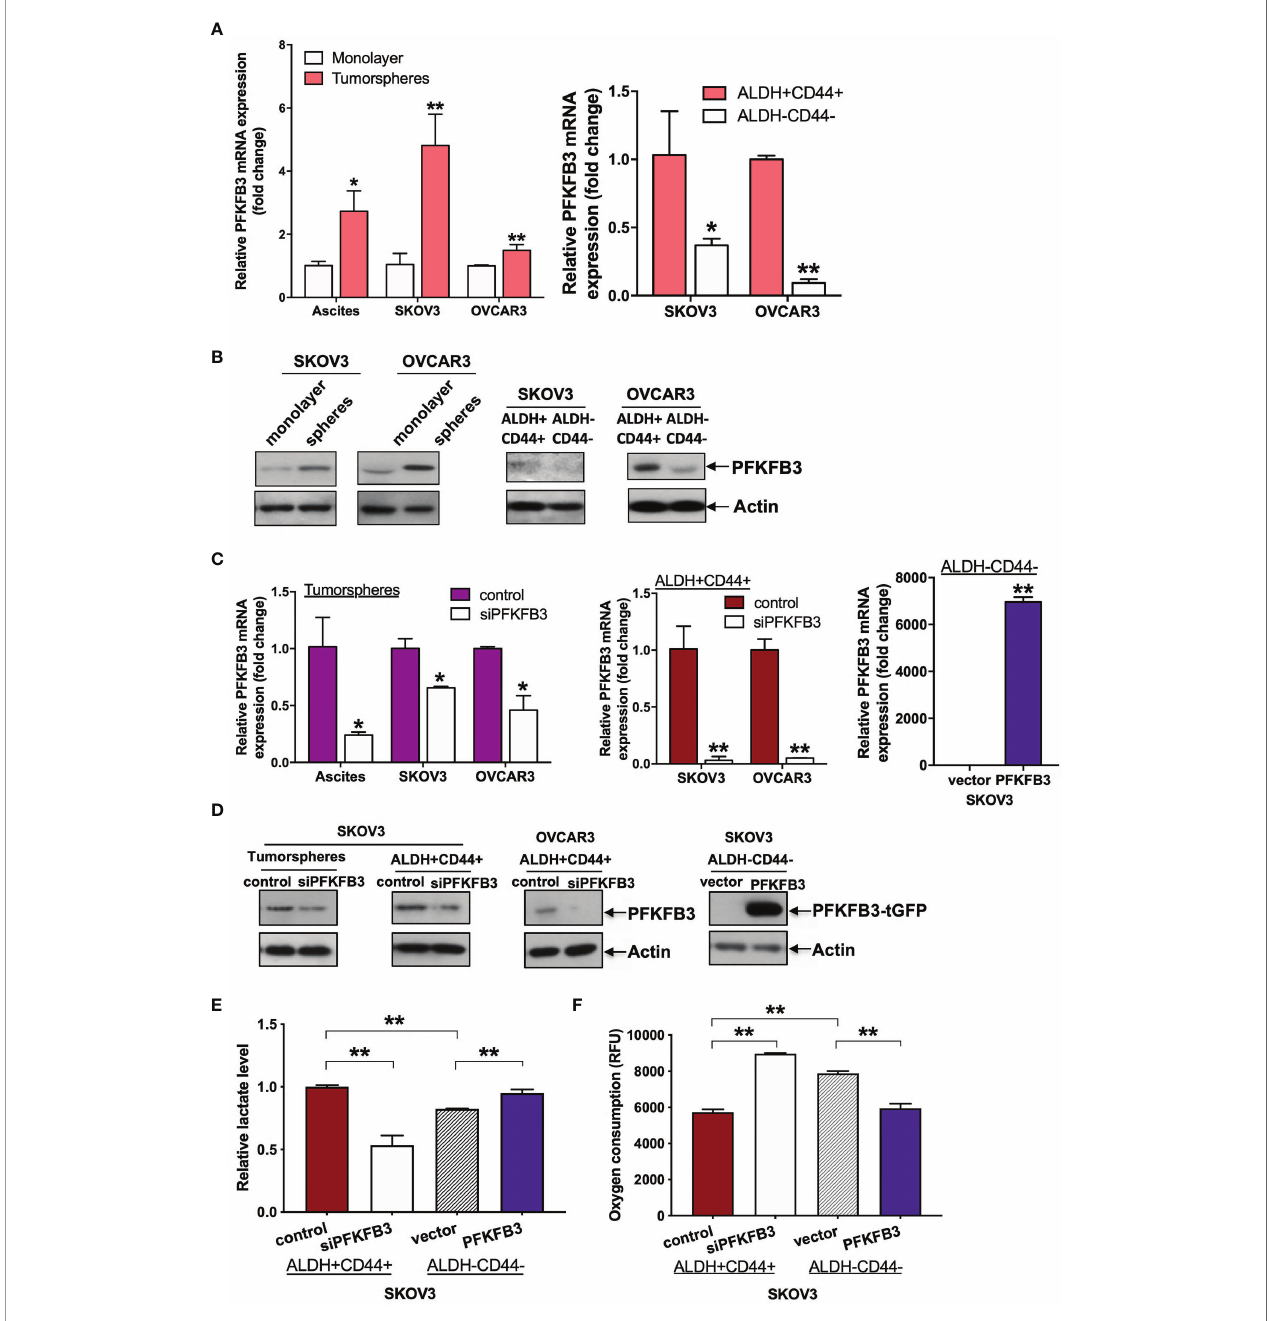
FIGURE 3 | PFKFB3 shifts CSC metabolism in ovarian cancer. (A) Relative mRNA expression of PFKFB3 in tumorsphere/monolayer and ALDH+CD44+/ALDH- CD44- cells via qPCR. (B) Protein expression of PFKFB3 in tumorsphere/monolayer and ALDH+CD44+/ALDH-CD44- cells, determined via immunoblotting; Relative PFKFB3 (C) mRNA and (D) protein expression in tumorspheres and ALDH+CD44+ cells transfected with control siRNA or siPFKFB3 duplexes and PFKFB3- overexpressing ALDH-CD44- cells, determined by qPCR and immunoblotting, respectively. (E) Relative lactate production and (F) oxygen consumption rate of PFKFB3-suppressing ALDH+CD44+ cells and PFKFB3-overexpressing ALDH-CD44- cells after 24 h incubation. (n = 3; *p < 0.05, **p <